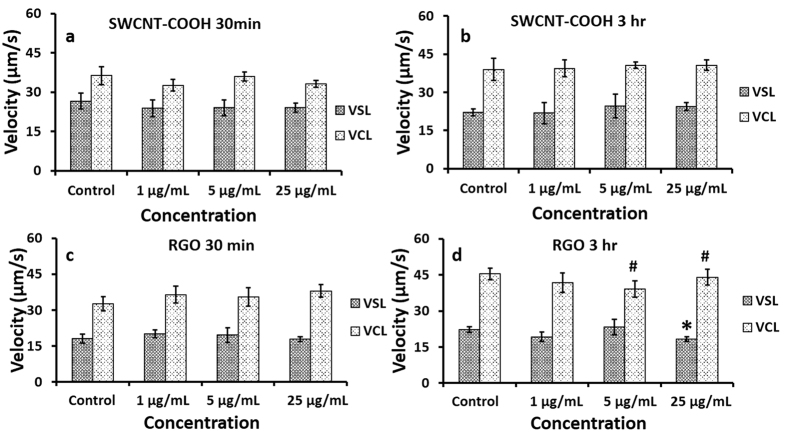
Sperm kinematic analysis at various SWCNT-COOH/RGO concentration and exposure time.Linear (VSL) and curvilinear (VCL) sperm velocity for sperm samples (control, 1, 5, and 25 μg/mL) incubated with SWCNT-COOH for (a) 30 min and (b) 3 hours, as well as, incubated with RGO for (c) 30 minutes and (d) 3 hours. *p value < 0.05 between VSL of sperm incubated with RGO and control samples, N = 3. #p value < 0.05 between VCL of sperm incubated with RGO and control samples, N = 3. Error bars represent a standard error of the mean.